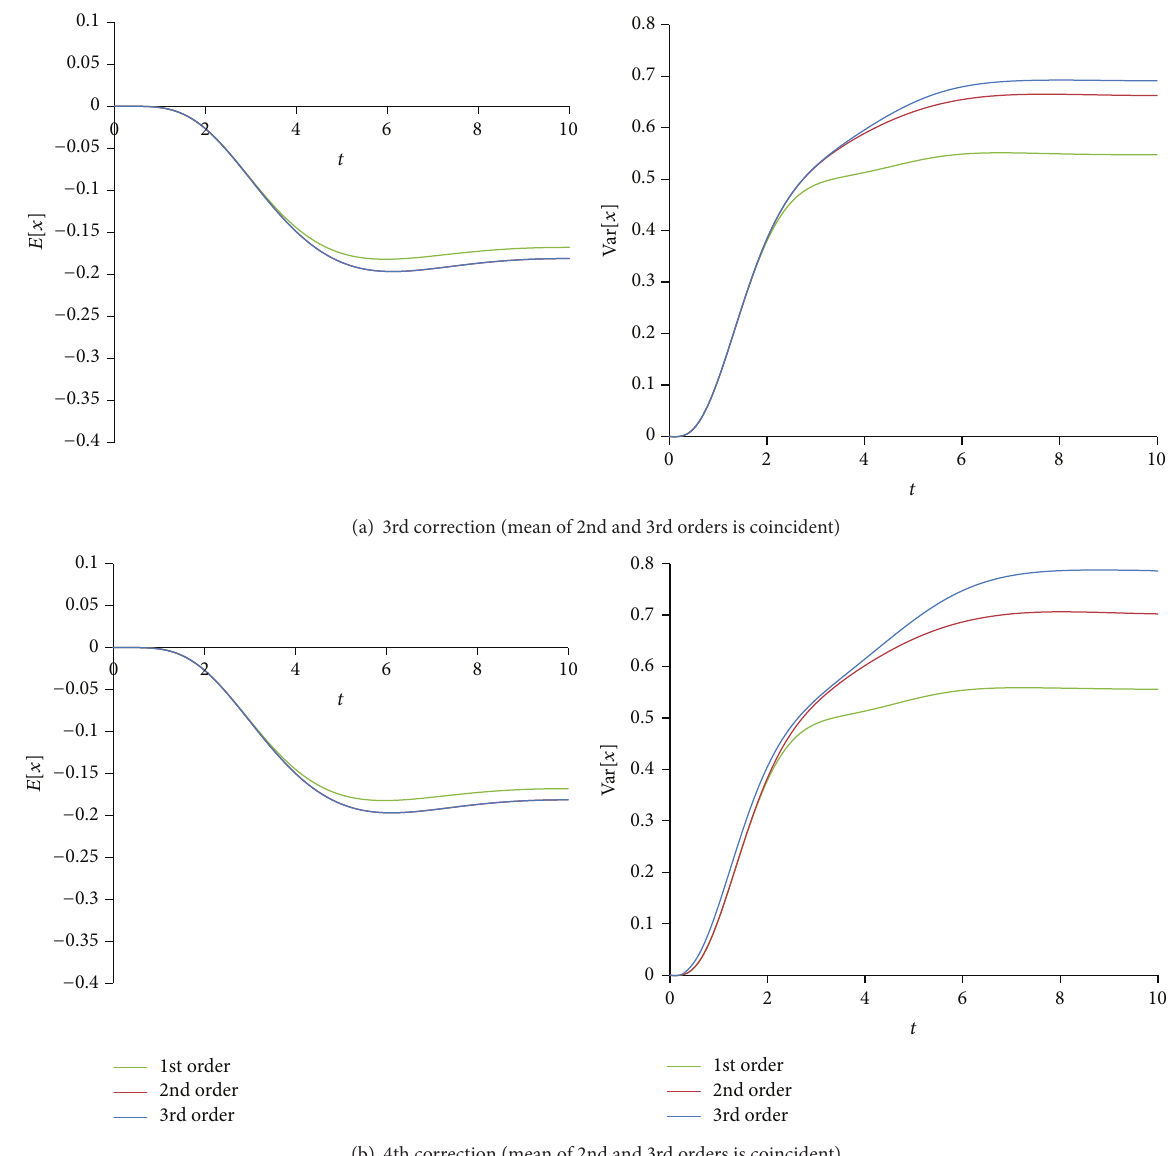
Figure 13: Comparison between the response mean and variance for the first, second, and third orders with numbers of corrections 3 and 4, 𝜀 = 0.3 .